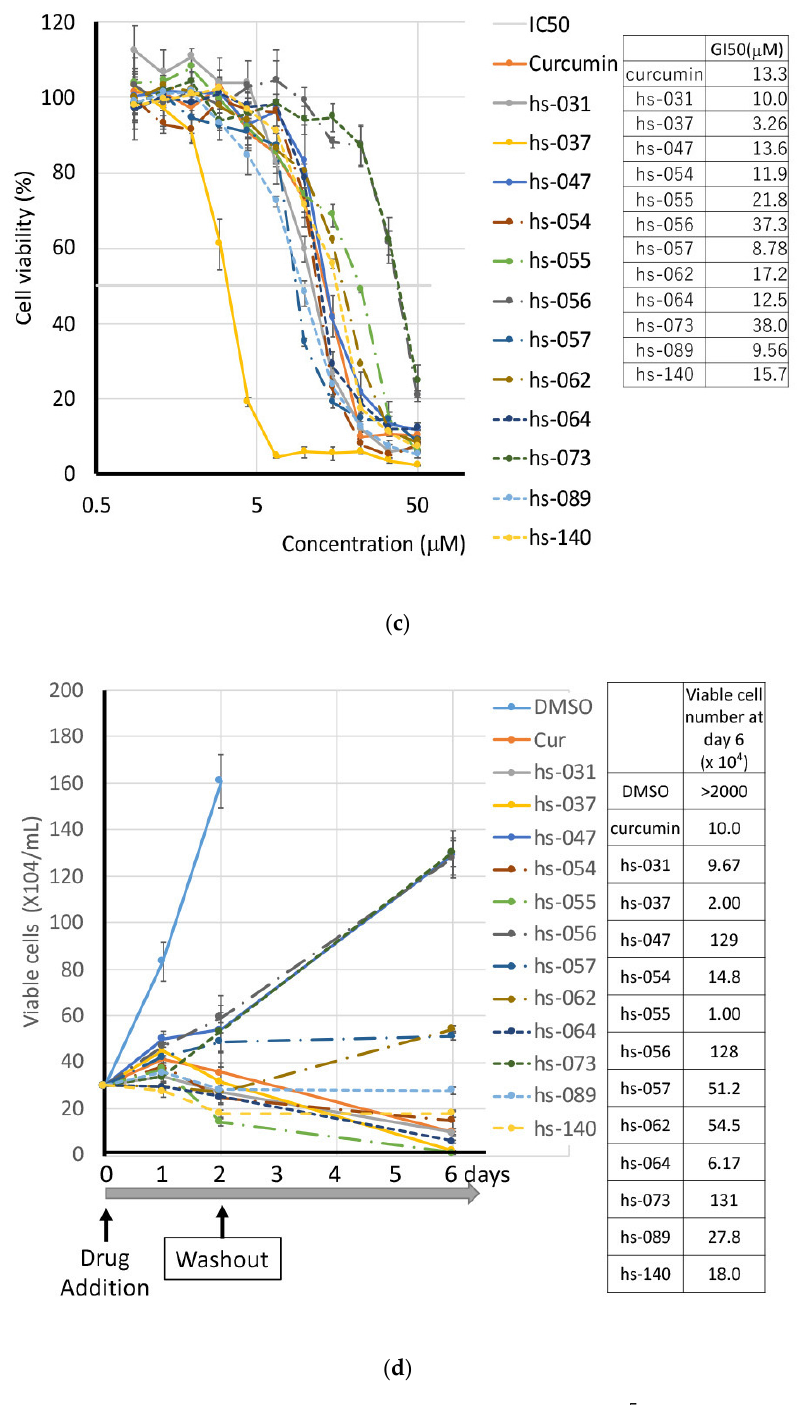
Figure 2. Growth inhibition by curcumin derivatives. ( a , b ) K562 cells (10 5 cells / mL) were cultured in the presence of each compound (50 µ M) for 4 days. Cells were enumerated every day using the trypan blue staining method. The results for viable ( a ) and dead ( b ) cells are shown. ( c ) The GI 50 of curcumin derivatives on K562 cells was determined after a 4-day culture. ( d ) K562 cells (3 × 10 5 cells / mL) were cultured in the presence of each compound for 2 days, washed once and transferred to the fresh medium without either compound. Viable cells were counted by the trypan blue exclusion method.